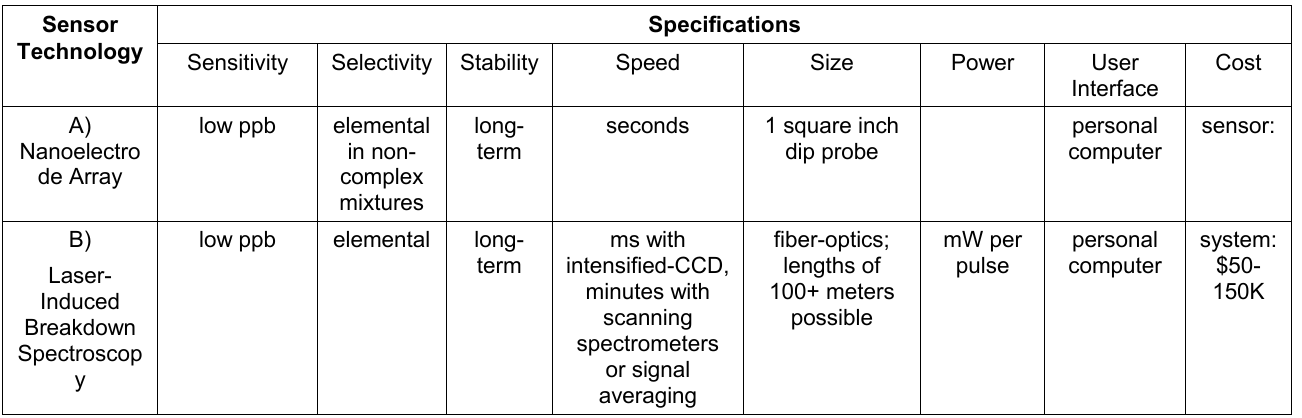
Table 10. Summary of specifications for trace metal